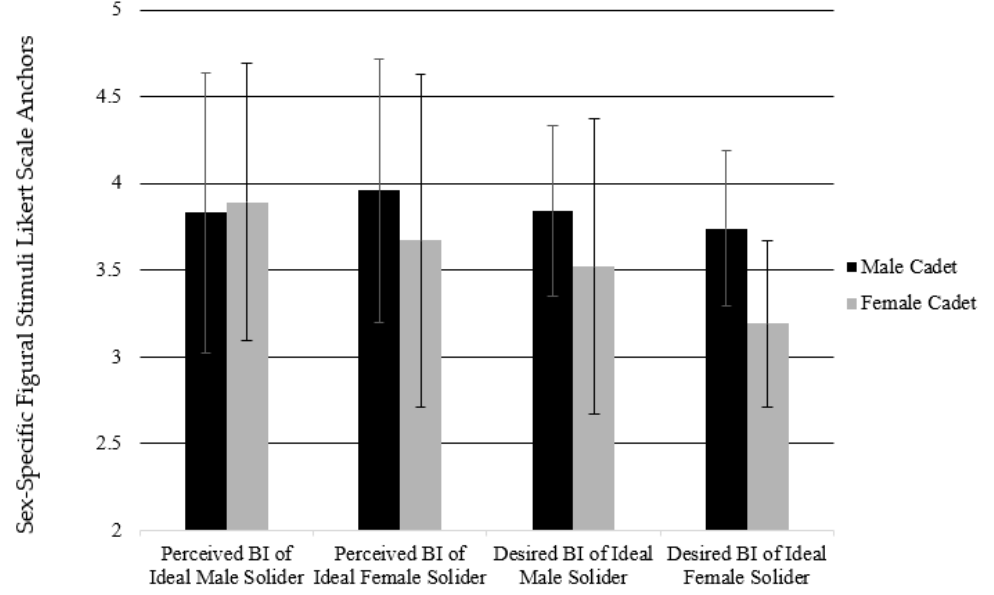
Figure 3. Body Image Perceptions reported by cadets on soldiers. Scores using sex-specific figural stimuli Likert Scale Anchors [21].